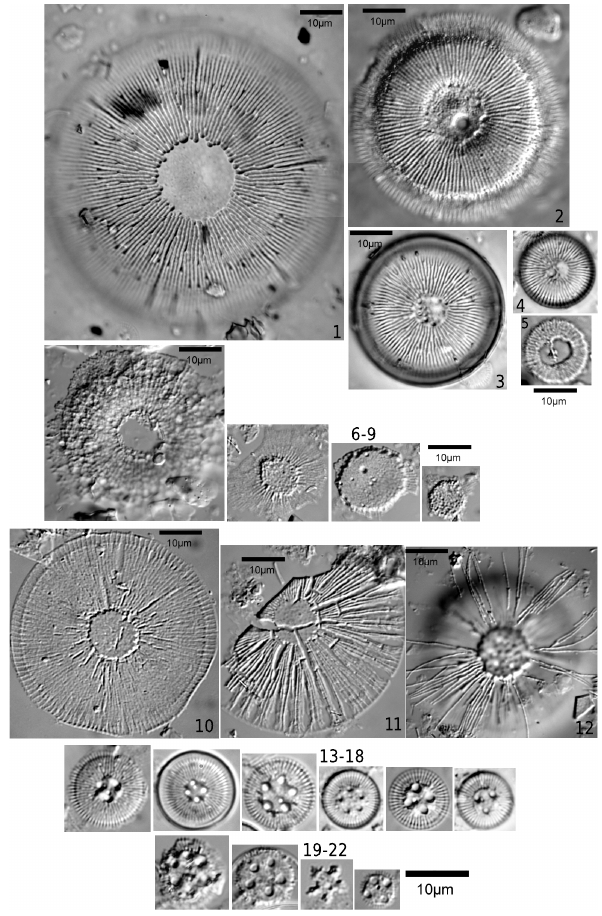
Fig. 3. Light micrographs of representative valves of Cyclotella fot- tii Hustedt (Figs. 1–12; × 1000 magnification) and C. ocellata Pan- tocsek (Figs. 13–22; × 1500 magnification). 1, 7–9, 10–12